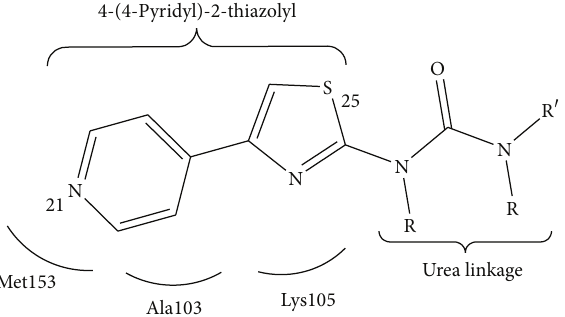
Figure 2: Representation of atoms used in different alignments.